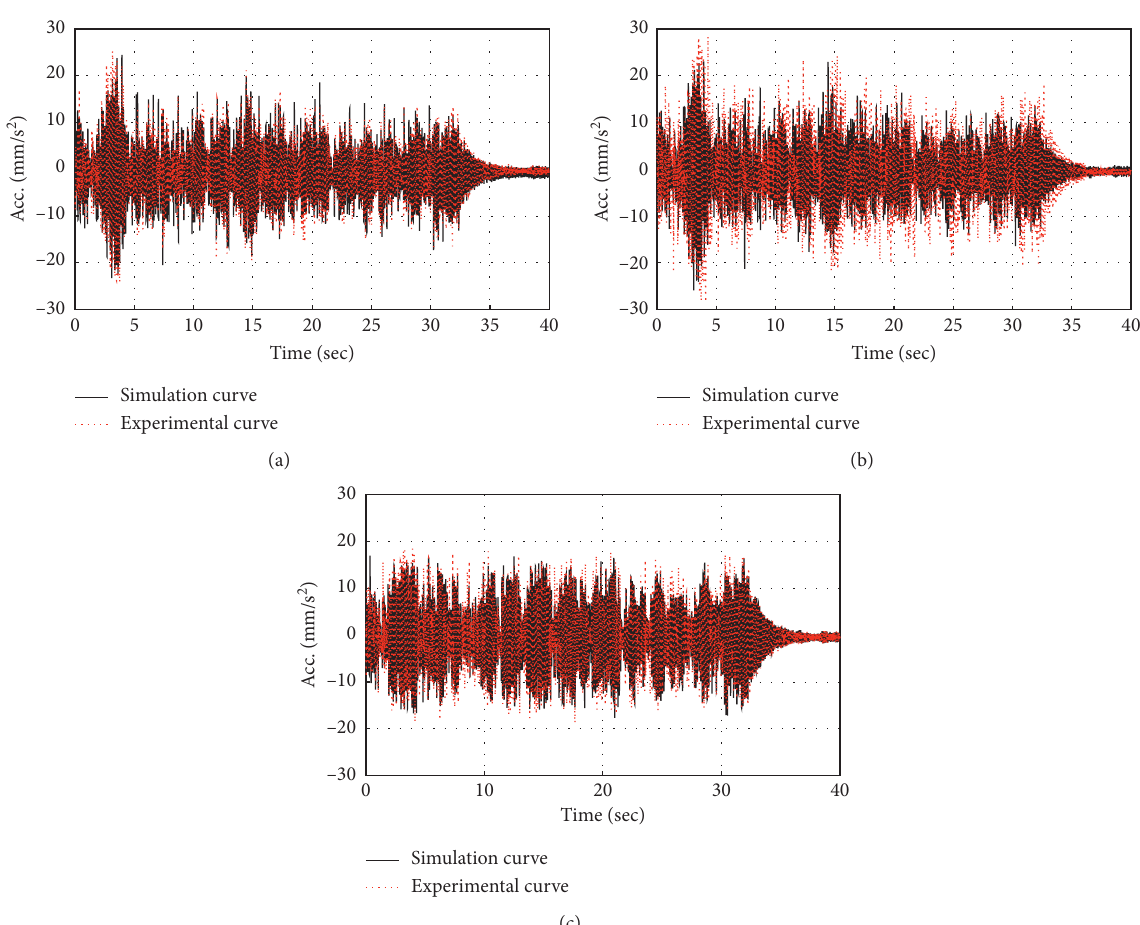
Figure 12: Time-histories of the acceleration response: (a) point 9; (b) point 15; (c) point 27.